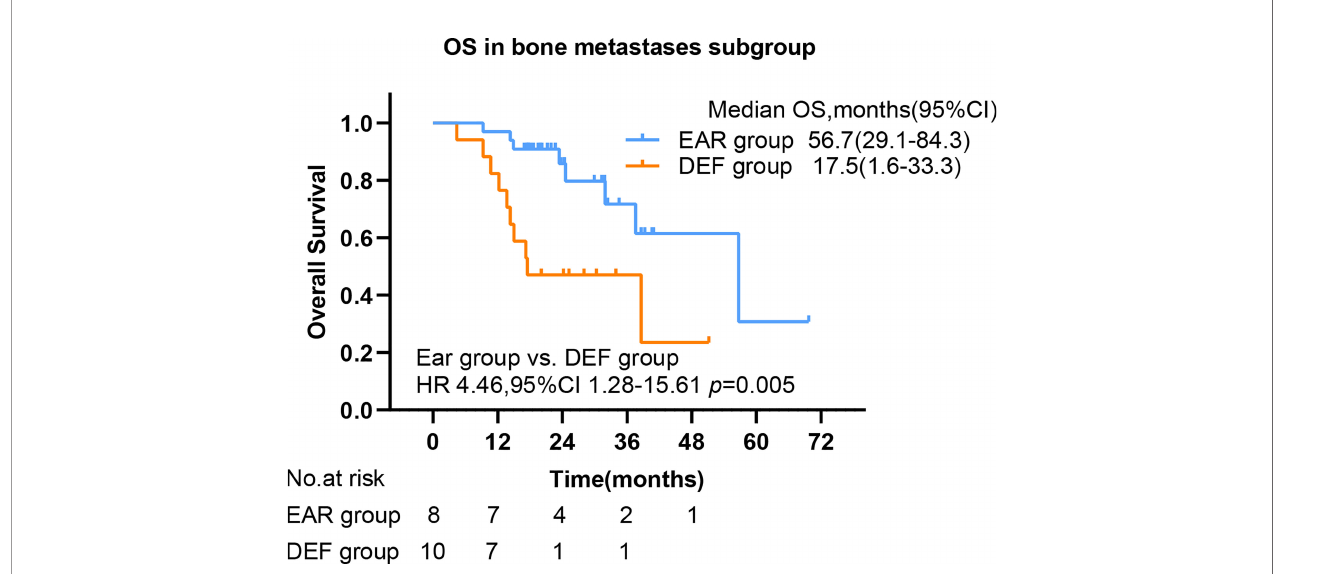
FIGURE 5 | The OS by bone metastasis. PFS, progression-free survival; OS, overall survival; CI, con fi dence interval, EAR, early to initiate radiotherapy group ( ≤ 53 days); DEF, deferred radiotherapy group (>53